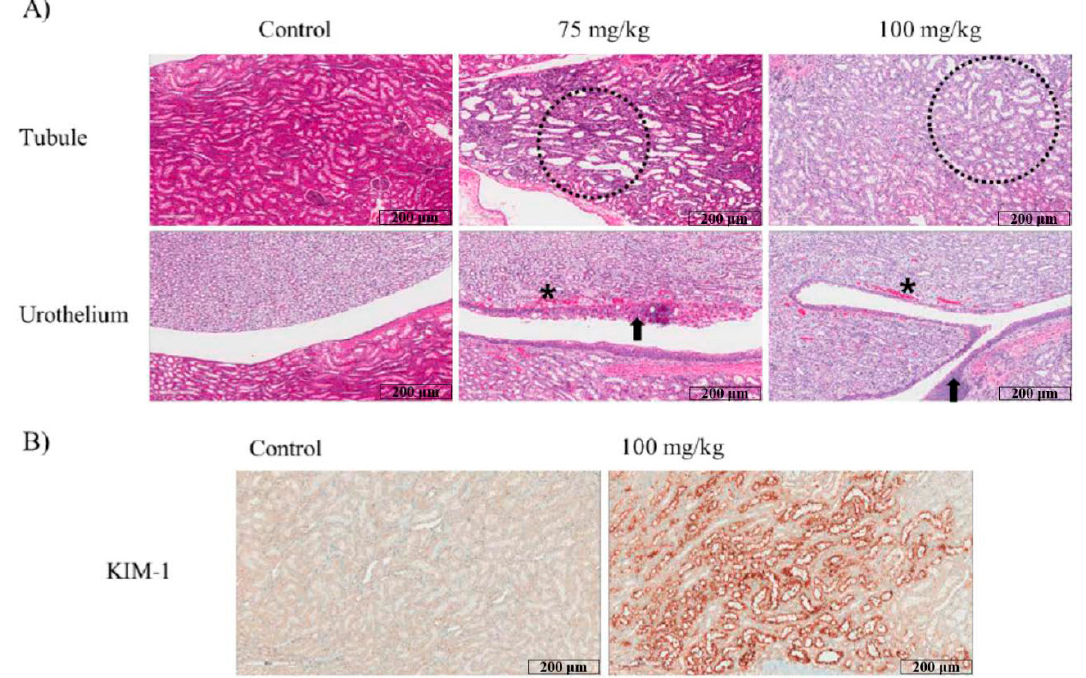
Figure 1. Histopathological changes in the kidney after 1 week consecutive ifosfamide (100 mg/kg) administration. ( A ) H&E-stained sections of kidney after 1 week of ifosfamide intraperitoneal injection. Dashed circle indicated tubular degeneration/dilatation. Arrow and asterisk indicated epithelial hyperplasia and focal hemorrhage/congestion, respectively. ( B ) Kidney section from 100 mg/kg group was found to have evidently increased KIM-1 expression in tubule area when compared to the control group.